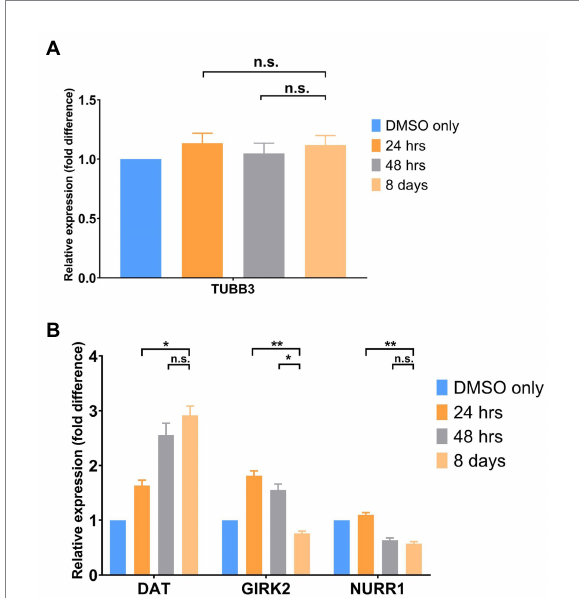
FIGURE 3 Gene Expression by qPCR. (A) SGC0946 treatment does not increase the number of total neurons as measured by expression of TUBB3 (BetaIII Tubulin). (B) SGC0946 treatment potentially increases the number of dopaminergic neurons as measured by the expression of TH and Dopamine Transporter (DAT). Data suggests that a short treatment is preferred for the midbrain DA neurons as measured by the midbrain DA neuron marker GIRK 2. NURR1 is a widely expressed marker on neurons, microglia and other cell types. Experiments were performed in three replicate wells of neuron differentiation and drug treatment. Error bars indicate SEM. * p < 0.05, ** p < 0.01, n.s., not